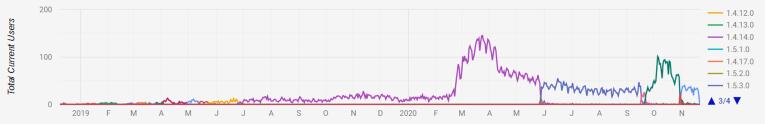
BWDAT weekly users per version since its first version (Output from Chrome Developers Interface on the 22nd November 2020).